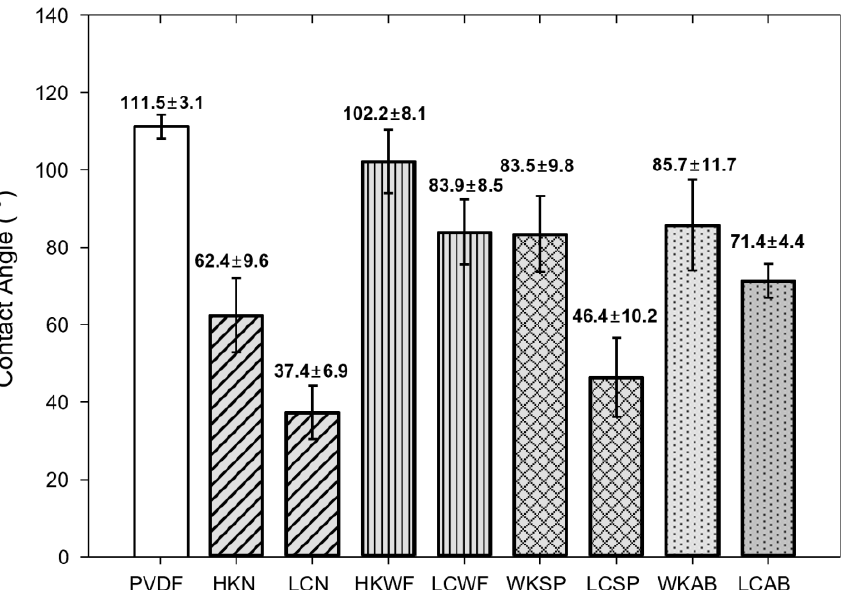
Figure 8. Contact angle results. PVDF is the CA result of the virgin membrane before MD operation. LDs were expressed as HCOOK to HK and LiCl to LC. LDs with cleaning methods were abbreviated to HKN for HK with no cleaning, HKWF for HK with WF, HKAB for HK with AB, and HKSP for HK with SP. Similarly, LCN for LC with no cleaning, LCWF for LC with WF, LCAB for LC with AB, and LCSP for LC with SP.